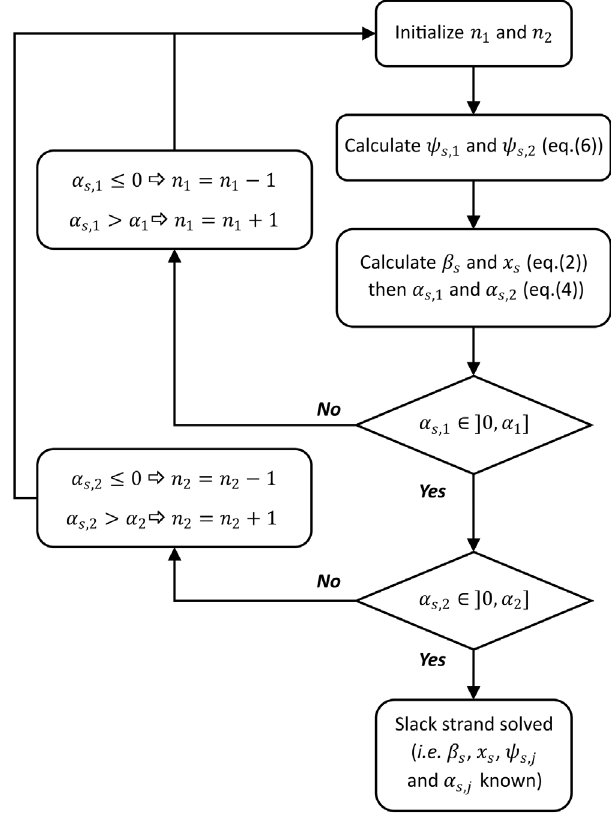
Fig. 9. Flow chart for the slack strand